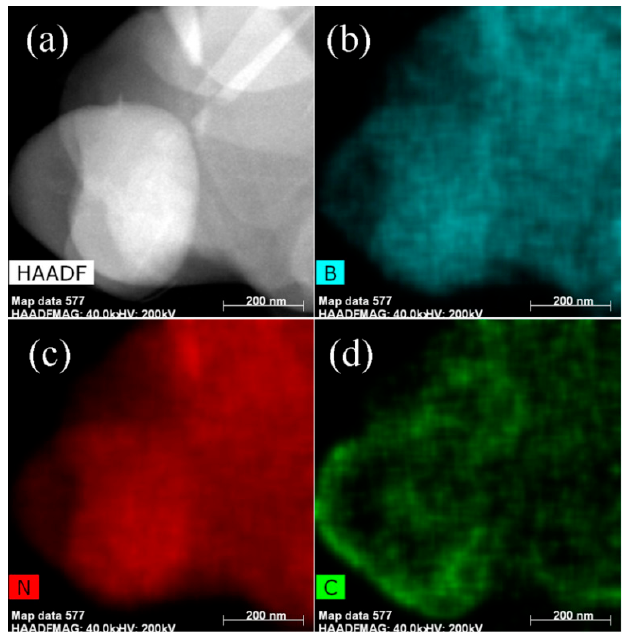
Figure 2. ( a ) HAADF-STEM image of the BNNSs@C-15 hybrids; ( b – d ) EDX elemental maps of B, N, and C, respectively.